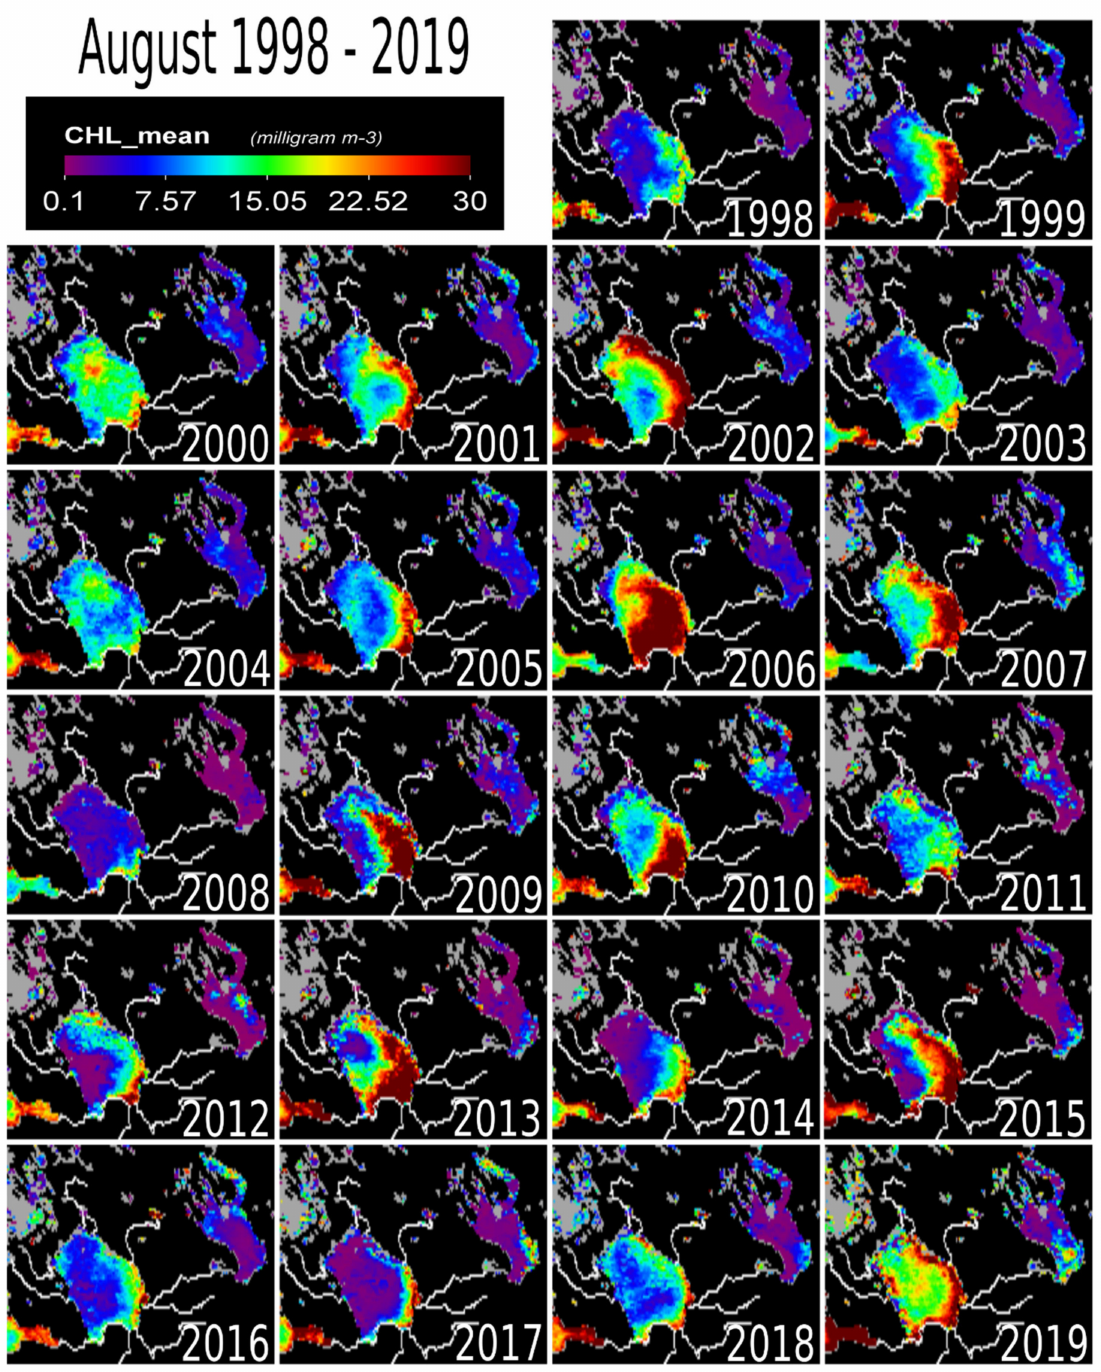
Figure 5. The map of chlorophyll-a concentration at Lake Ladoga for the month of August (1998–2019). Partially displayed as reference points are the Gulf of Finland (Southwest) and Lake Onega